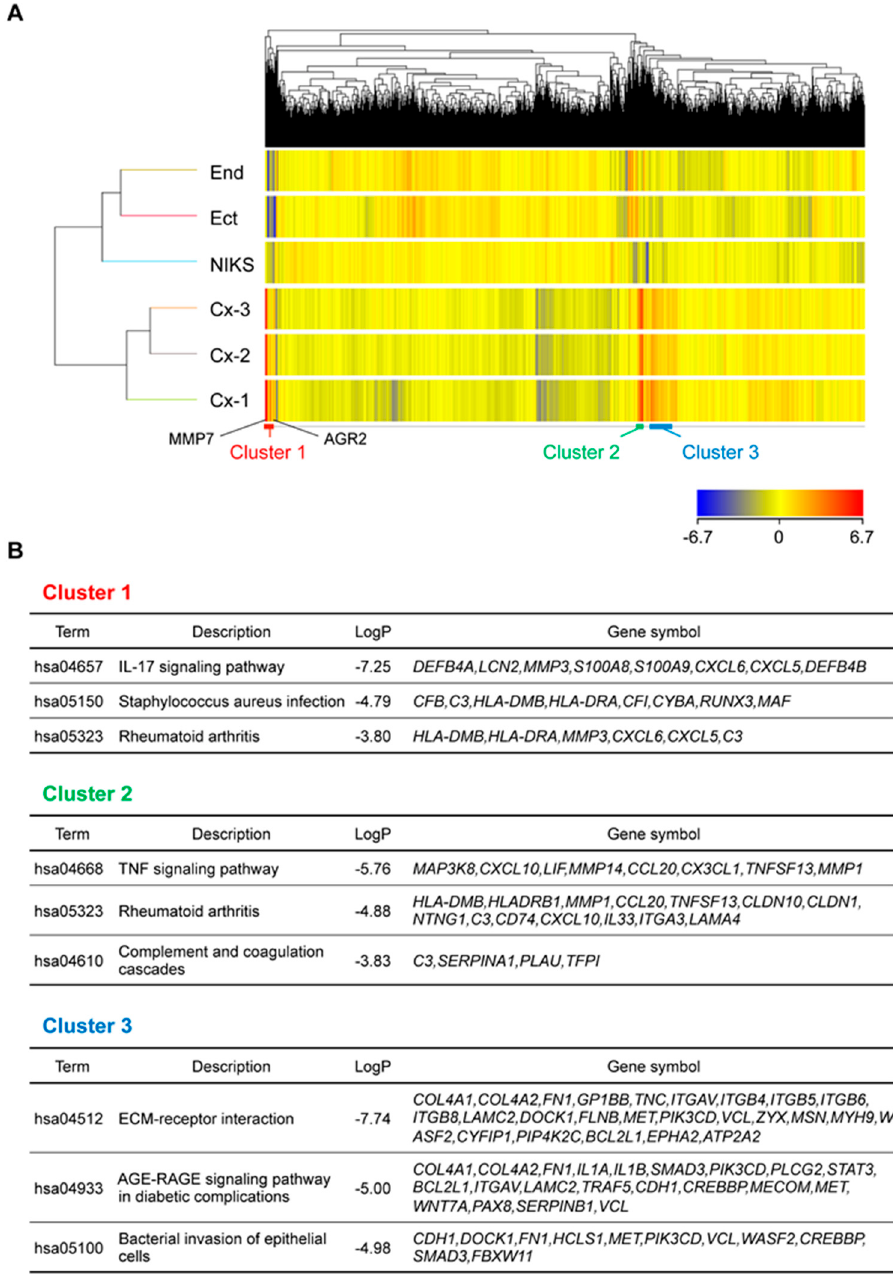
Figure 4. Transcriptome analysis of SCJ-derived organoids. ( A ) Heat map for two-way clustering analysis. SCJ-derived immortalized cell lines: End, Ect, and NIKS, and three SCJ-derived organoids Cx-1 to Cx-3 were analyzed. Note that MMP7 and AGR2 were included in Cluster 1. ( B ) Clusters of specifically upregulated genes in SCJ-derived organoids.